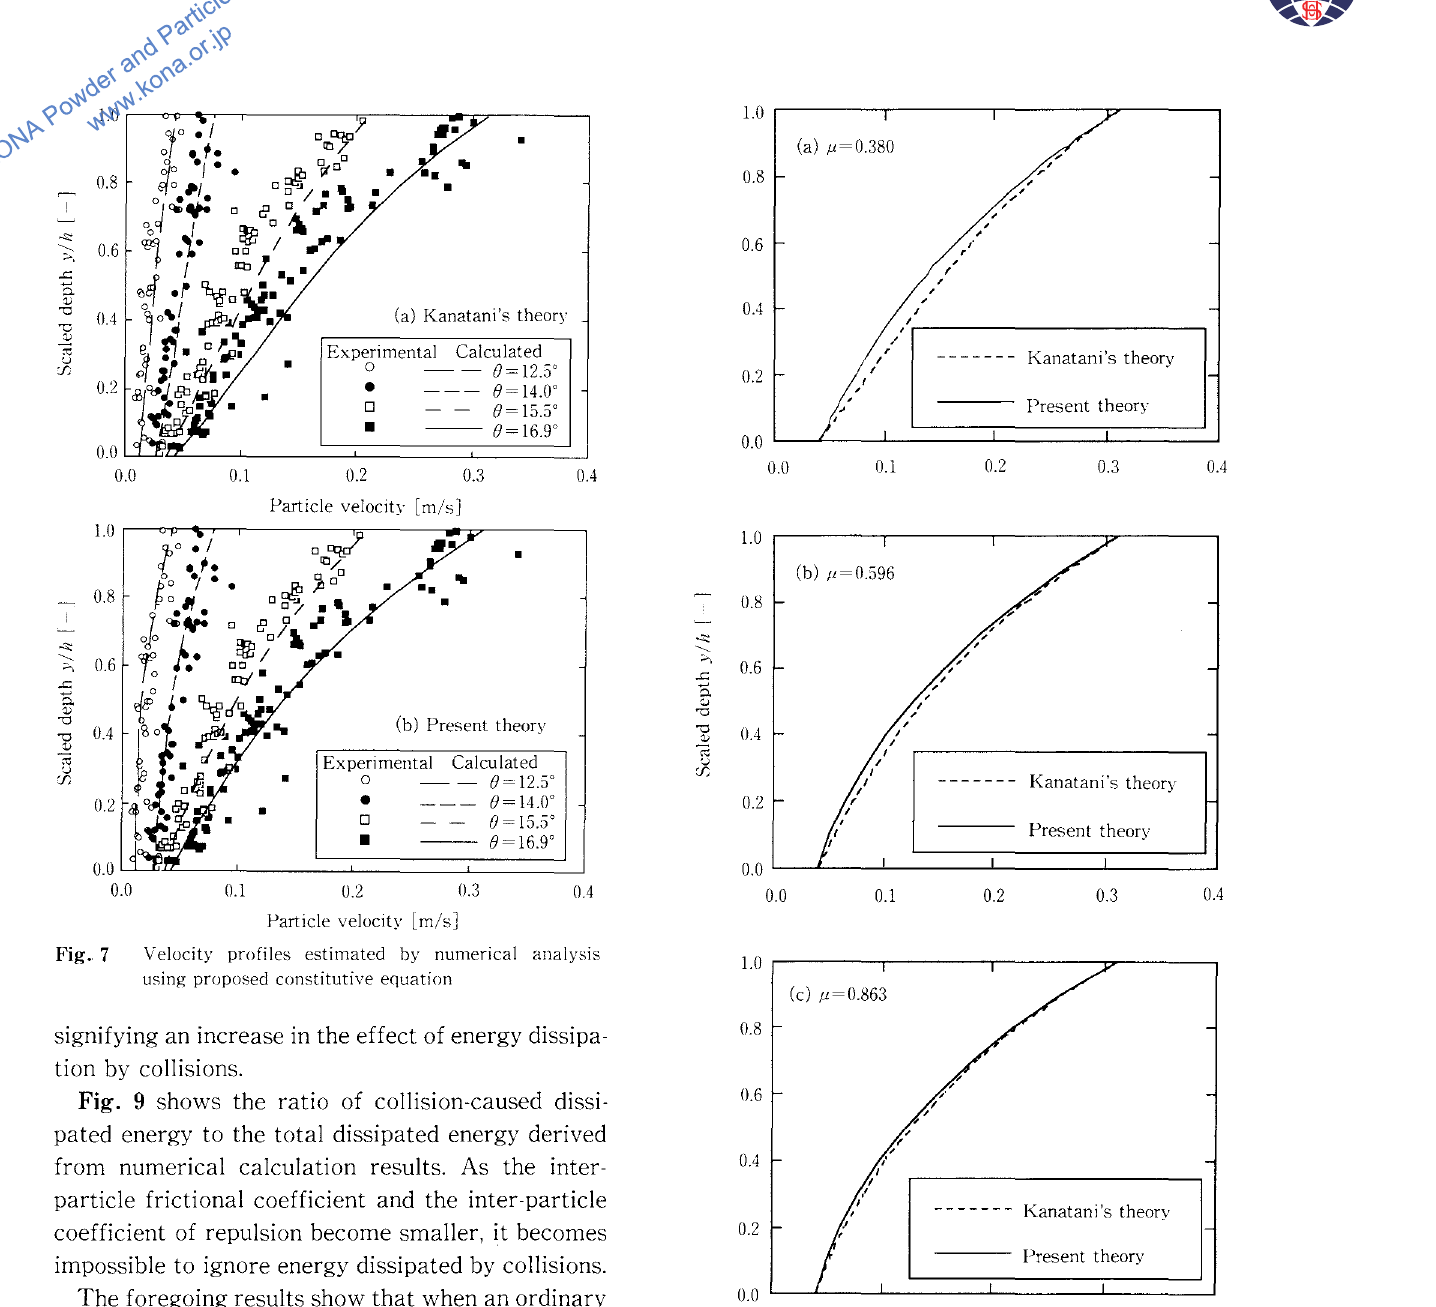
Effect of coefficient of friction between particles on particle velocity distribution constitutive equations derived by Kanatani to take collision-caused energy dissipation into